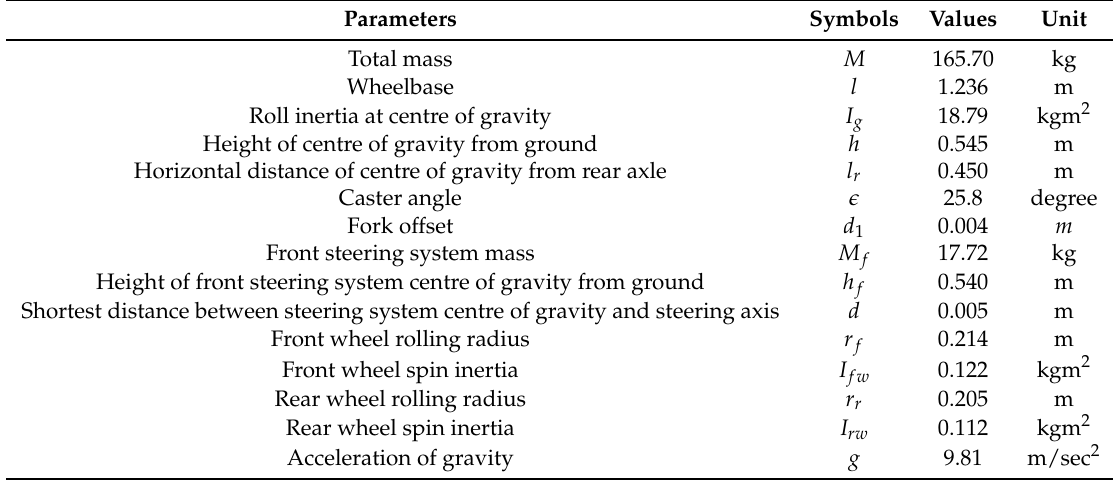
Table 1. Layout, mass and inertia of the motorcycle including a rider weighing 65 kg.